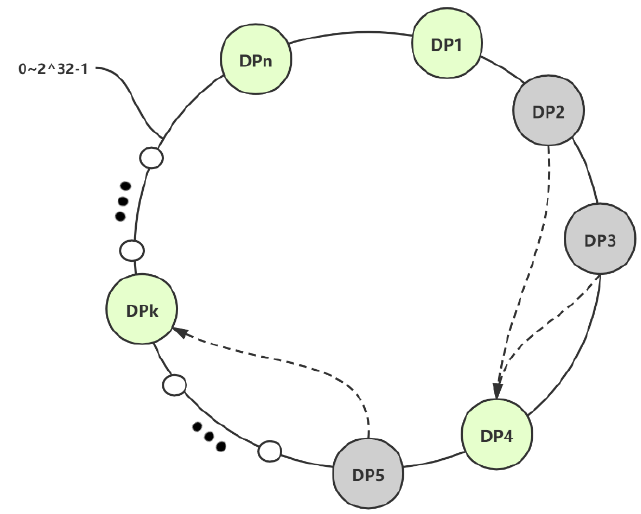
Figure 1. Ring topology.